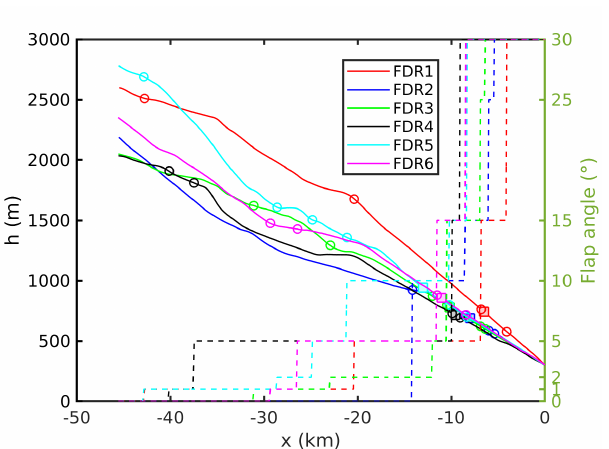
Figure 5. Flight trajectories for the approach phase with respect to distance to final approach with flap configuration changes (circles) and corresponding angles (dashed lines), and landing-gear-down configuration